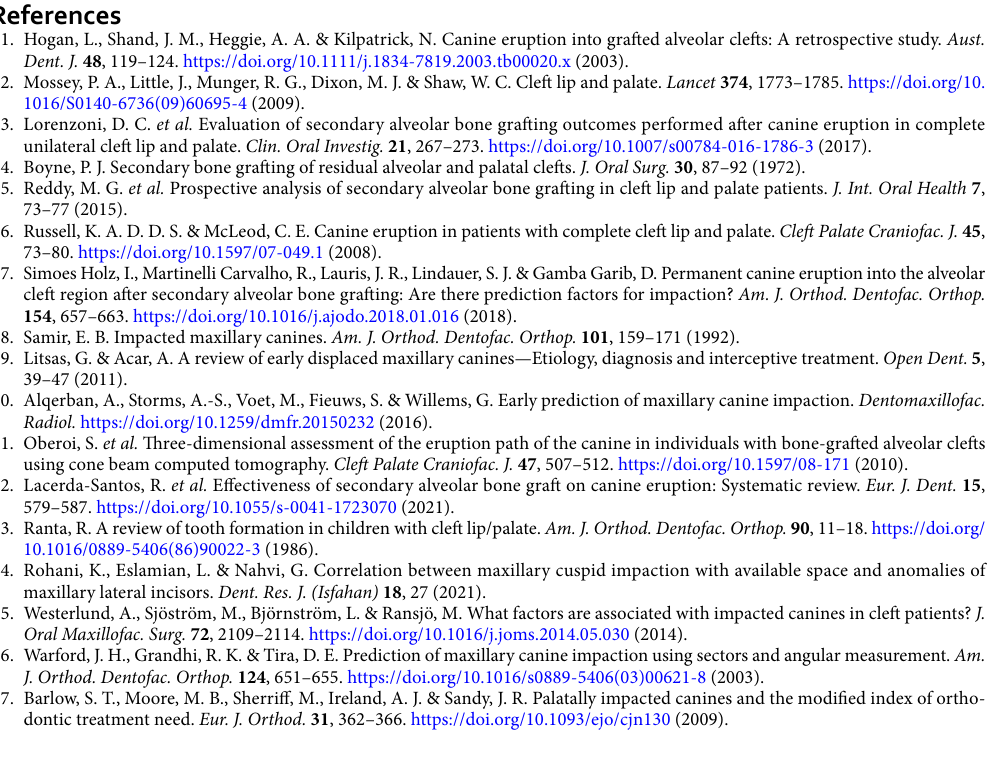
Figure 1. Measurement of canine movement and distance on CT 3D images. (A) Arrangement of CT 3D images with 3D coordinates. The midpoint of Or on both sides was set as the origin (O). The plane connecting the three points of the orbitale (Or) on both sides and the porion (Po) on the healthy side mark the XY plane. The plane perpendicular to the XY plane through Or on both sides is the XZ plane. The plane perpendicular to the XY and XZ planes through the origin (O) is the YZ plane. (B) The distance between the cleft side canine and the lateral cleft margin of T1. O origin, α the shortest distance between the lateral cleft margin and the cleft side cusp tips of a canine; β, The shortest distance between the lateral cleft margin and the mesial side of the maximum contour of the cleft side canine. (C) The virtual tooth axis of canine was set as l . The line passing through the midpoint of the line connecting the mesial and distal sides of the canine crown and the cusp tip of the canine was used as the virtual tooth axis; ∠ θ 1 , minimum angle of canine axis to the XY plane. (D) ∠ θ 2 , minimum angle of canine axis to the XZ plane; ∠ θ 3 , minimum angle of canine axis to the YZ plan. (E) The (x, y, z) coordinates of the cusp tips of the canine were recorded. The distance was measured on the 3D superimposed image at pre-ABG and post-ABG (pre-ABG, white; post-ABG, gray). a. cusp tips of canine of non-cleft side; b. cusp tips of canine of cleft side; T1, pre-ABG; T2, post-ABG. Oa T1 : pre-ABG origin-to-canine distance on the non-cleft side, Oa T2 : post-ABG origin-to-canine distance on the non-cleft side, Ob T1 : pre-ABG origin-to-canine distance on the cleft side, Ob T2 : post-ABG origin-to-canine distance on the cleft